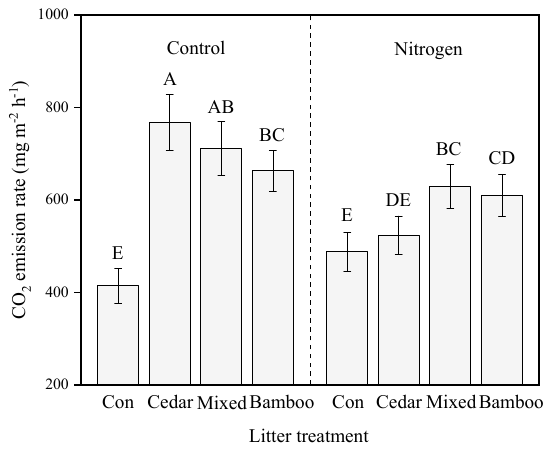
Figure 2. Soil CO 2 emission rates (mg m − 2 h − 1 , means ± se), as affected by nitrogen (control vs. nitrogen) and fine root litter (con, cedar, bamboo, or mixed litter by cedar and bamboo fine root) treatments. Means with different letters indicate significantly different in post-hoc tests.